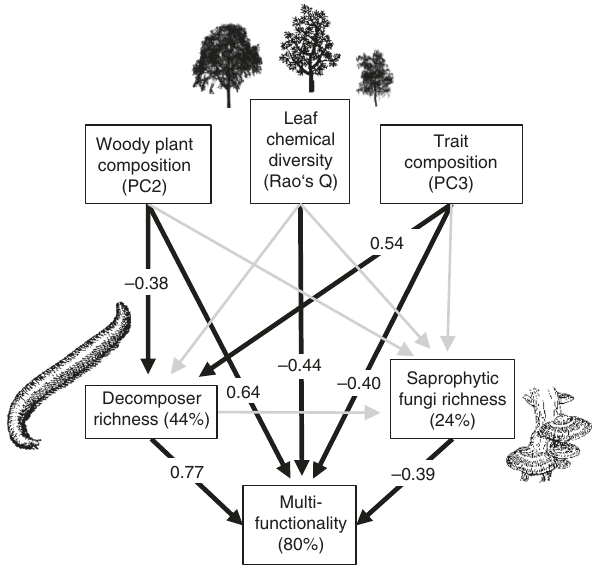
Fig. 2 Path model of biodiversity effects on average multifunctionality. Combined effects and interdependencies of the diversity and composition of woody plant communities and heterotrophic species richness on multifunctionality ( χ ² = 1.9, DF = 3, P = 0.598). Black arrows (with standardized path coef fi cients) indicate signi fi cant ( P ≤ 0.05) effects, grey arrows show nonsigni fi cant effects. Percentage values are explained variance of endogenous variables. The plant, fungi, and animal icons (from www.openclipart.org) are licensed for use in the public domain